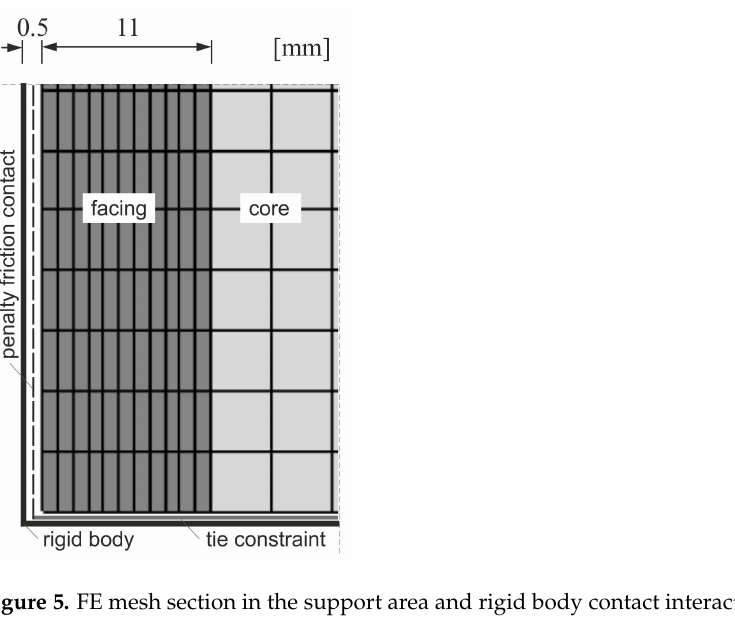
Figure 5. FE mesh section in the support area and rigid body contact interactions.